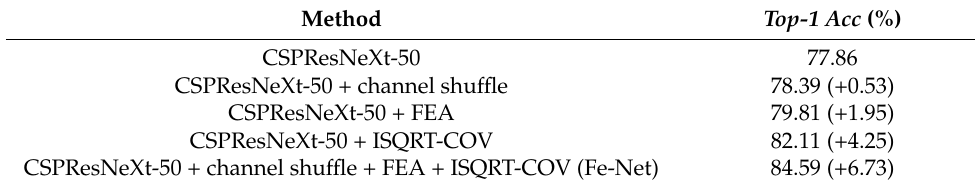
Table 2. Ablation experiment of Fe-Net.